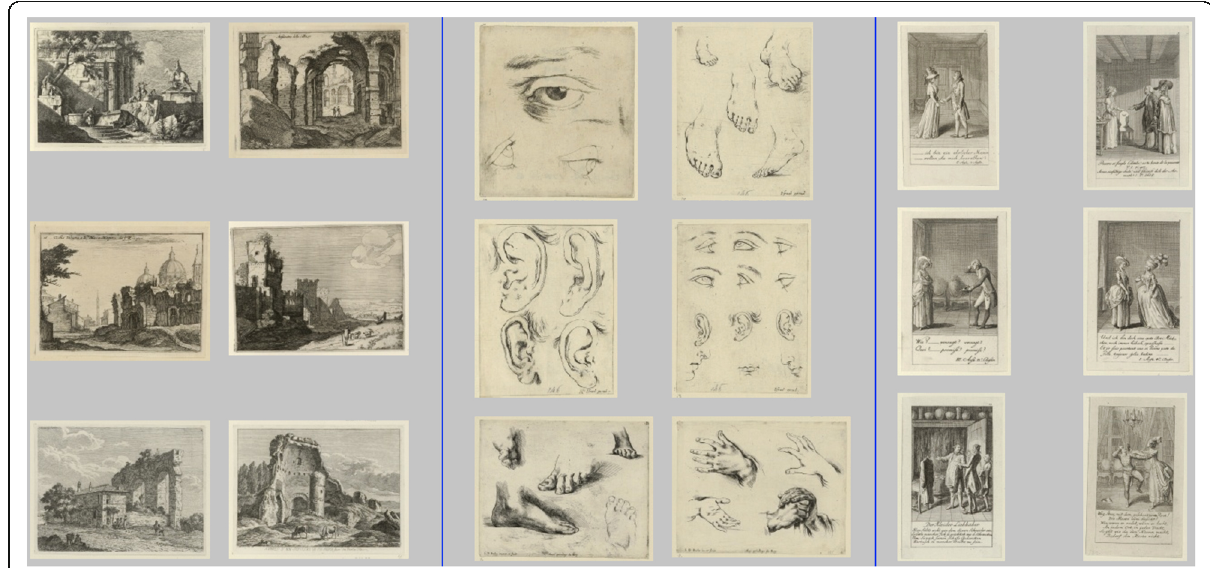
Fig. 15 Image examples of three of the LadeCA words created in the